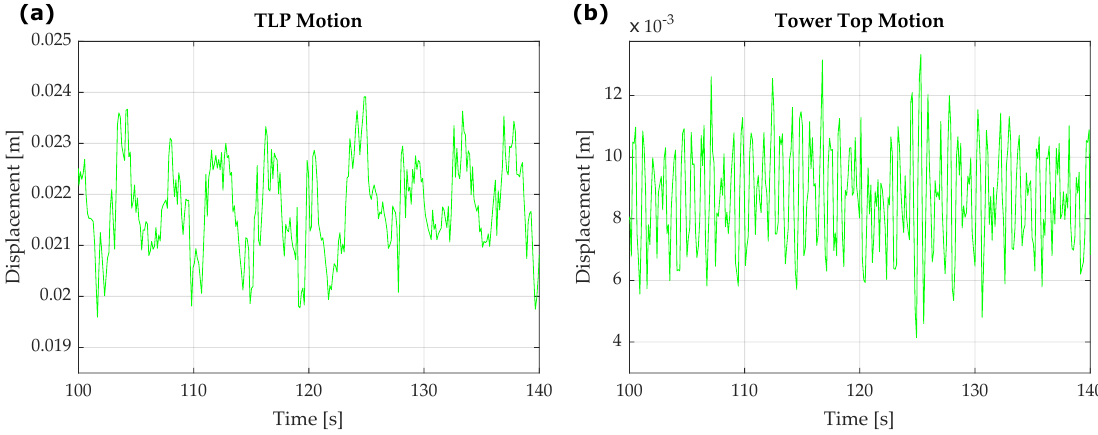
Figure 9. ( a ) Experimental time series data of the displacement of the TLP at a wind speed of 7 m/s. ( b ) Experimental time series data of the displacement of the tower top at a wind speed of 7 m/s. As the wind field generated in the experiments and the simulations are not the same in the time domain, not much information can be drawn from direct comparison. But by investigating the